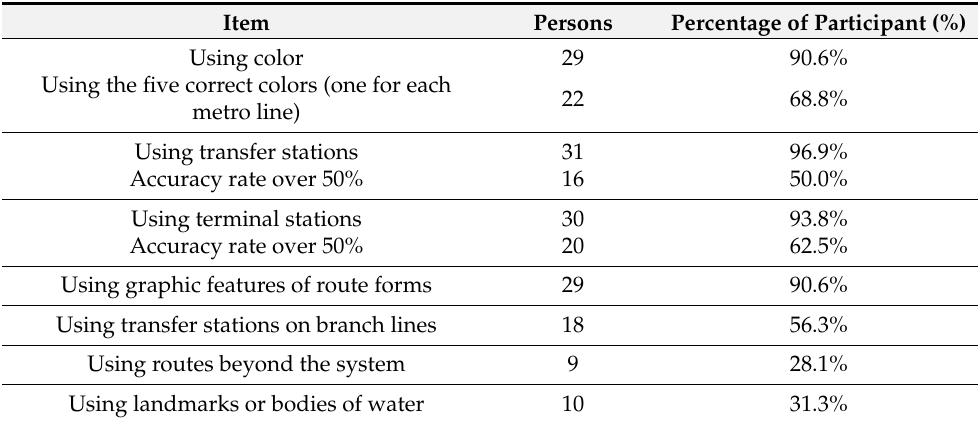
Table 3. Statistical results on the most frequently used elements in drawing a route map based on cognitive